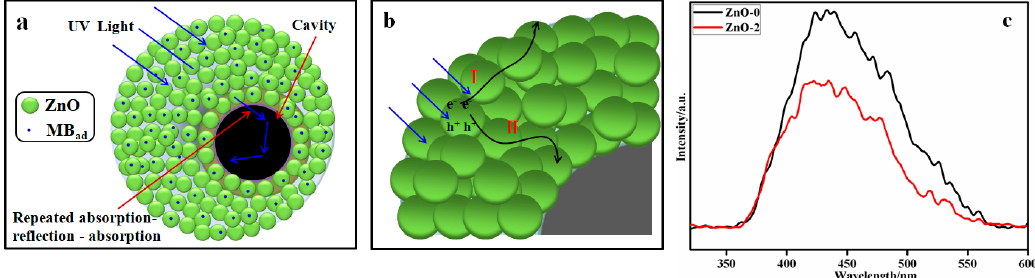
Figure 7. ( a ) Schematic drawing of highly efficient adsorption of the reactant molecules and high efficient absorption of irradiation light in the ZnO hollow sphere with porous sphere shell; ( b ) Schematic illustration for the migration process of the photogenerated electron in the sphere shell; ( c ) The photoluminescence spectra (PL) of the samples ZnO-0 and ZnO-2.